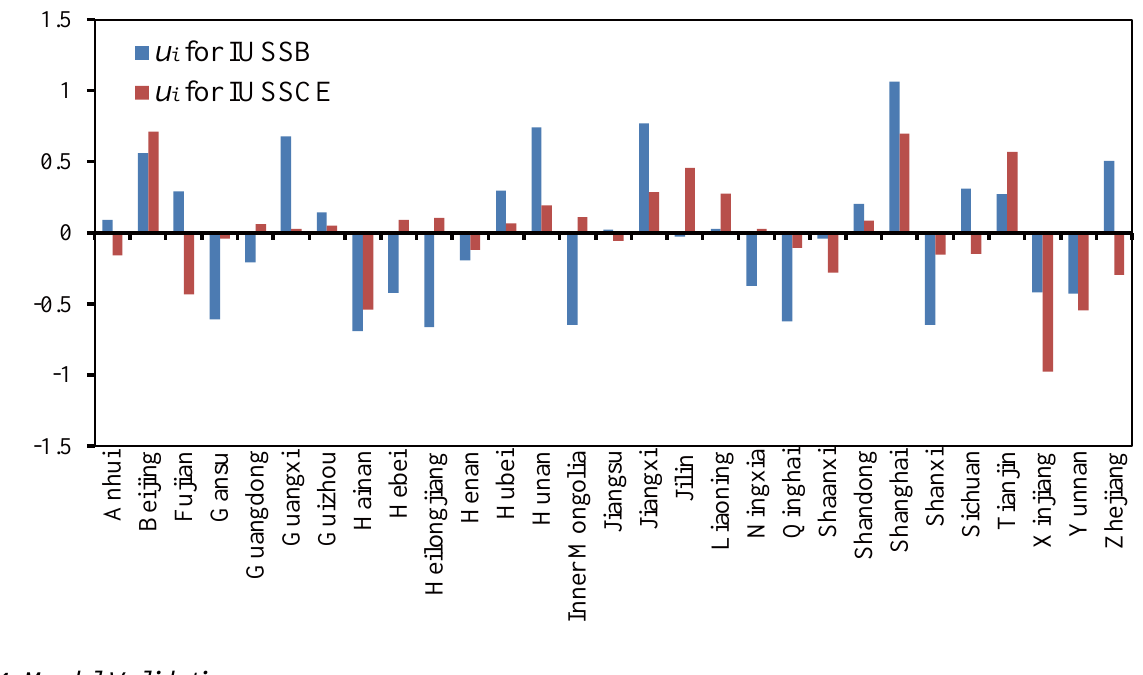
for each province in panel regression i